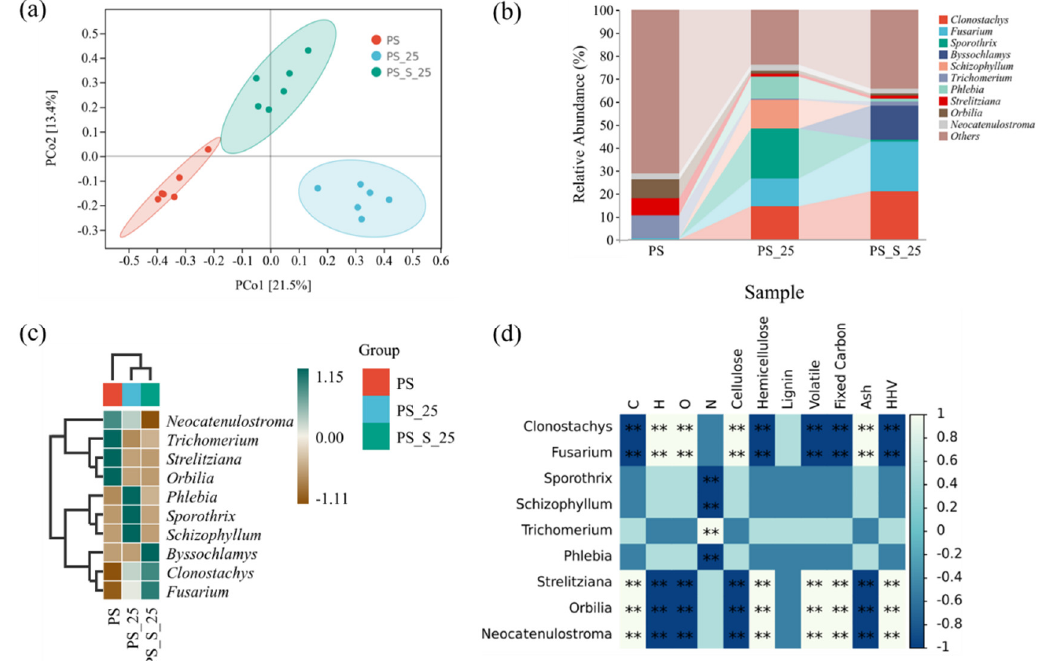
Figure 8. Fungi community analyzes conducted during PS, PS-25, PS-S-25 groups. ( a ) PCoA of the fungi communities in the compost based on DADA2, ( b ) Fungi level composition of the fungi community, ( c ) Heat map of species composition, ( d ) Corheatmap. ** There is a correlation, white is positive, dark blue is negative.